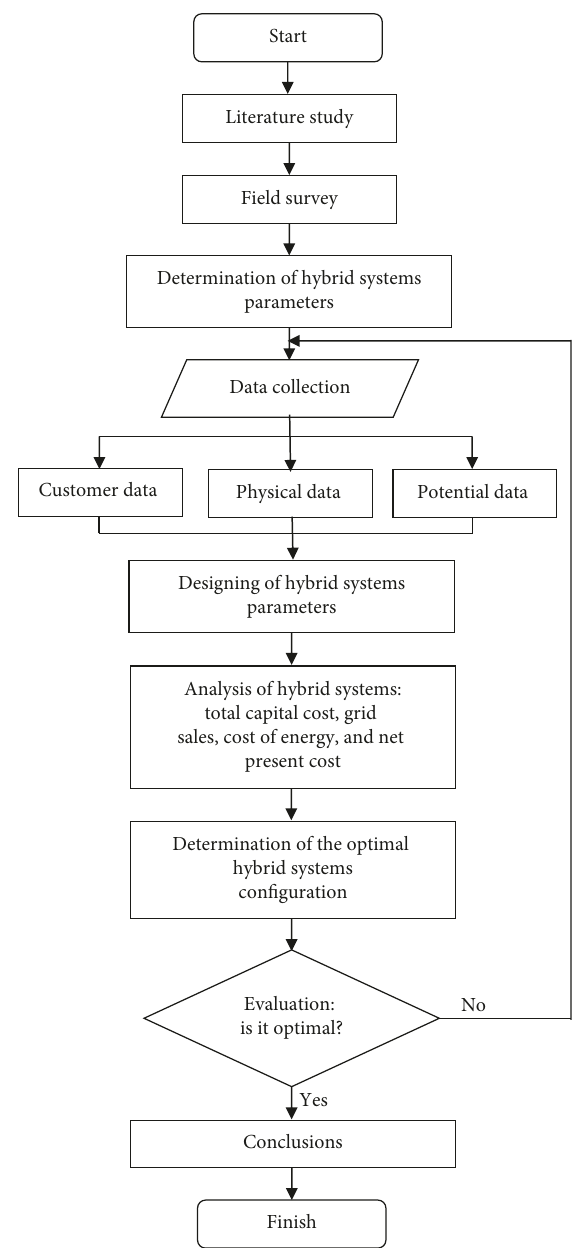
Figure 6: The procedures of this